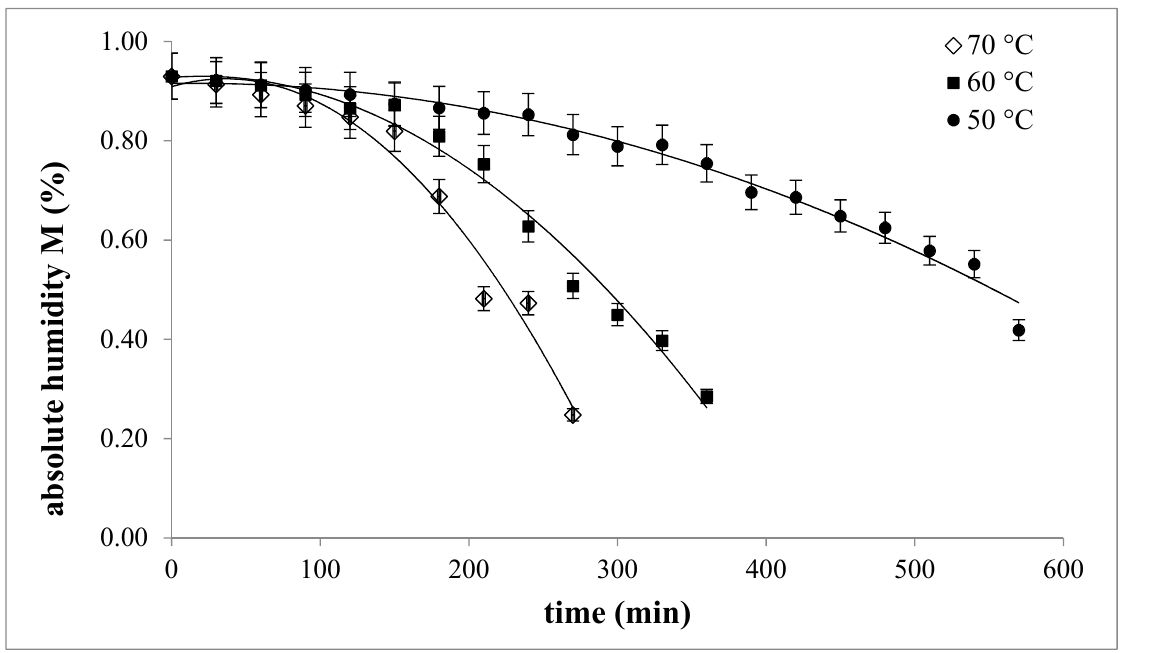
Figure 2. Trend of absolute humidity (M) during the drying process.